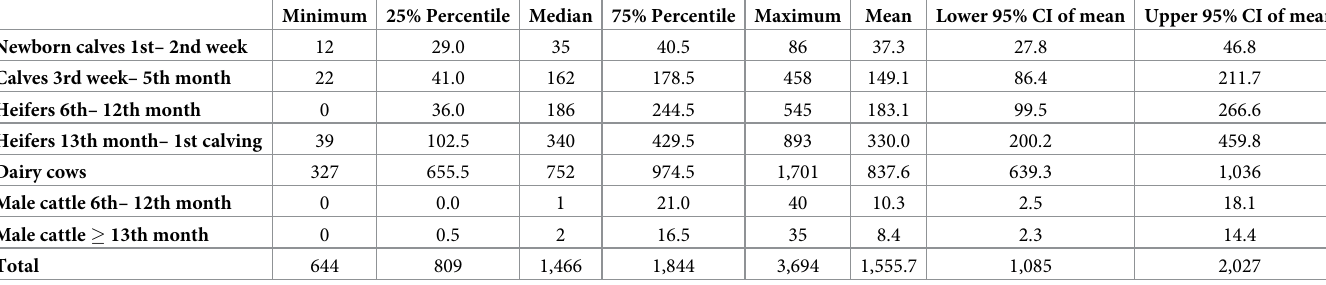
Table 2. Descriptive statistics of the average number of animals on the participating farms per age